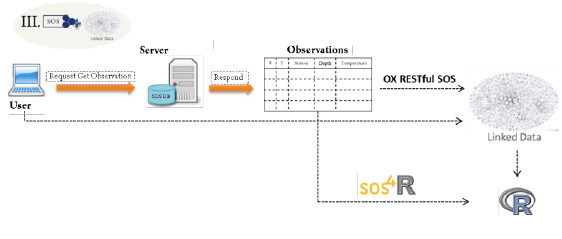
Figure 5. Option II: SOS + Linked data